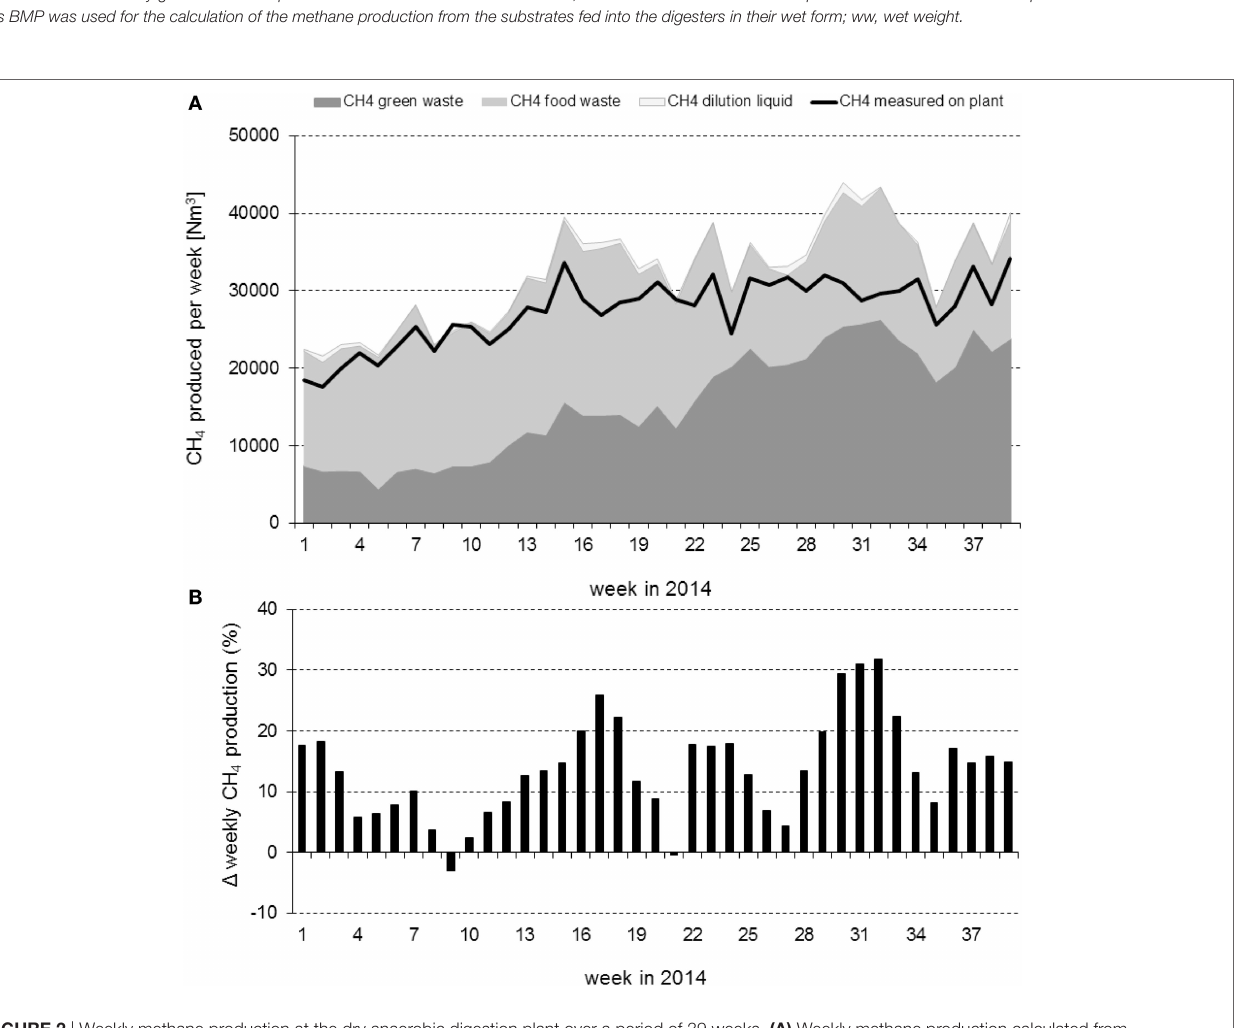
FigUre 2 | Weekly methane production at the dry anaerobic digestion plant over a period of 39 weeks. (a) Weekly methane production calculated from biomethane potentials of substrates and weekly organic loads (light and dark gray surfaces) and measured at the plant (black line). (B) Relative difference between measured and calculated methane